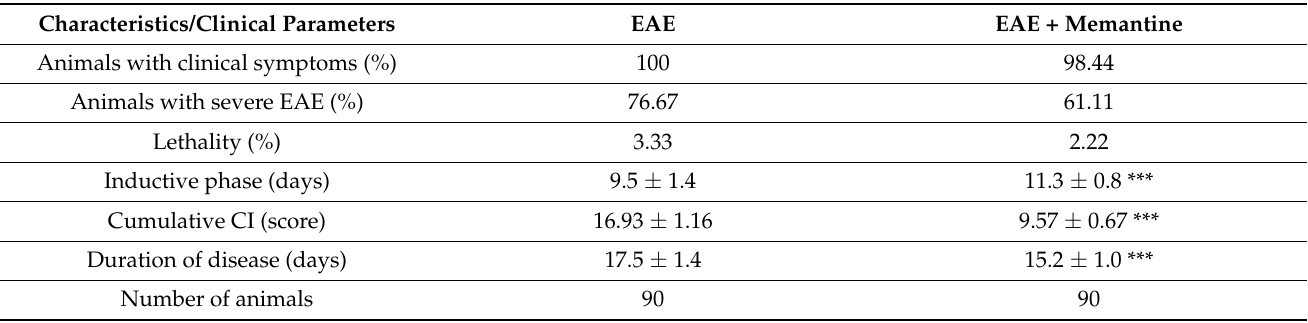
Administration of the NMDAR antagonist memantine reduced the neurological deficits and improved the condition of the experimental rats during the course of the disease. (CI, cumulative index). The values represent the means ± SD from n = 64 animals. *** p < 0.001 significantly different vs. experimental autoimmune encephalomyelitis (EAE) untreated rats (Student’s t